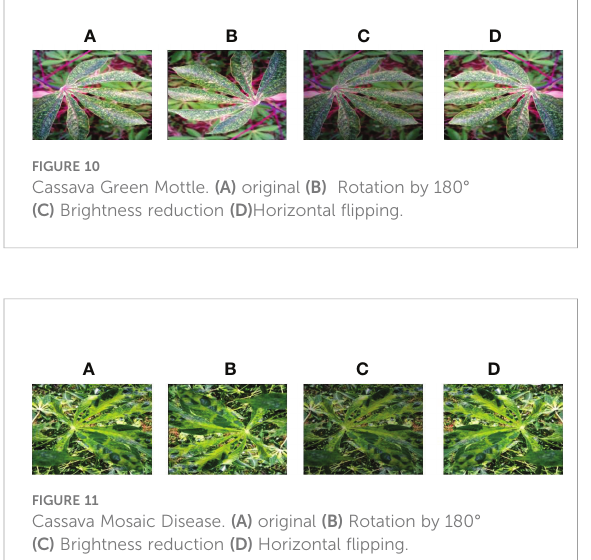
FIGURE 11 Cassava Mosaic Disease. (A) original (B) Rotation by 180° (C) Brightness reduction (D) Horizontal fl ipping.